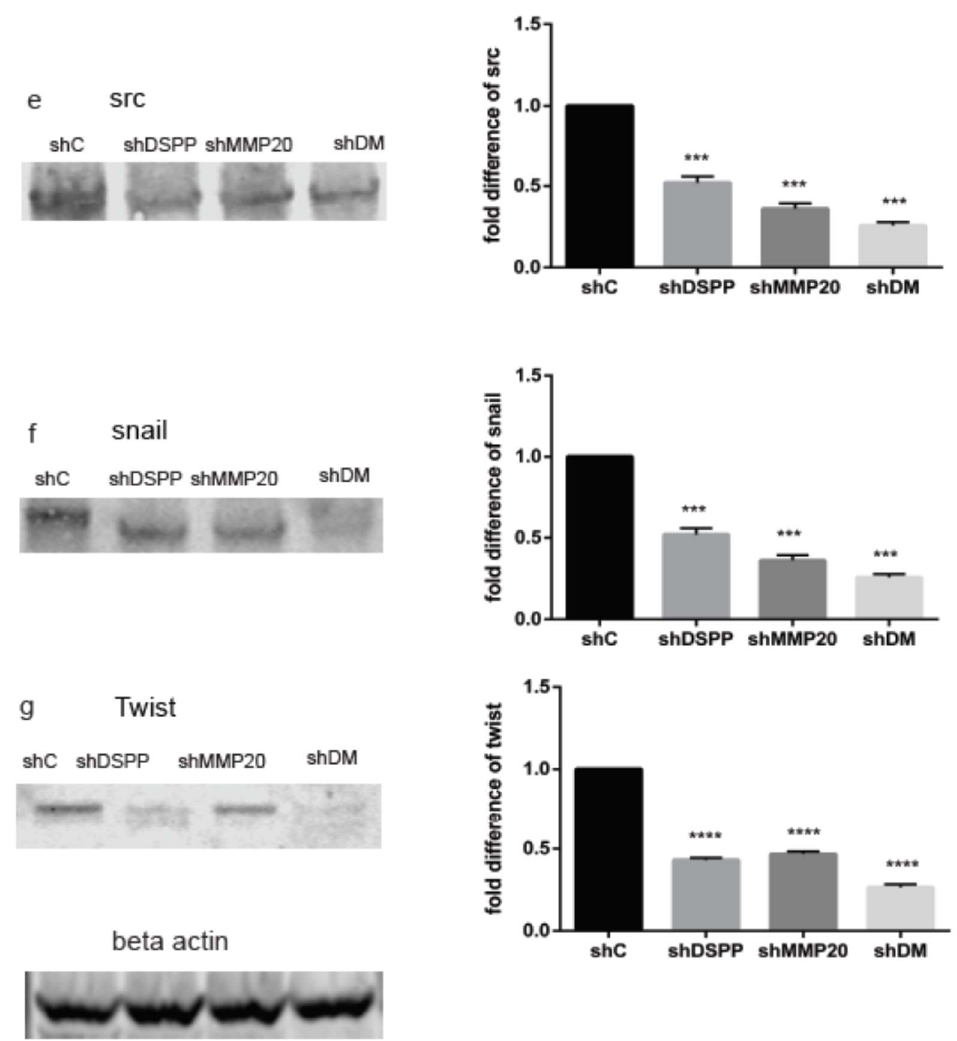
Figure 4. WB analysis of proteins associated with epithelial-mesenchymal transition. ( a ) Increase in level of E-cadherin (2-fold in shDSPP, 1.6-fold in shMMP20, and 1.8-fold in shDM ( p < 0.01, p < 0.05, p < 0.05, respectively) when compared to the control. ( b ) Decreased N-cadherin in shDSPP (93%), shMMP20 (54%), and shDM (84%) were significant ( p < 0.05) when compared to the control. ( c ) Decreased vimentin in shDSPP (73%), shMMP20 (55%), and shDM (79%) were significant ( p < 0.01, 0.001) when compared to the control. ( d ) Downregulation of met in shDSPP (80%), shMMP20 (30%), and shDM (47%) were significant ( p < 0.01) when compared to the control. ( e ) Downregulation of src (Figure 4e) in shDSPP (60%), shMMP20 (75%), and shDM (85%) were significant ( p < 0.01) when compared to the control ( f ) Downregulation of snail in shDSPP (46%), shMMP20 (60%), and shDM (74%) were significant ( p < 0.05) when compared to the control. ( g ) Downregulation of twist in shDSPP (44%), shMMP20 (50%), and shDM (70%) were significant ( p < 0.001) when compared to the control. Beta actin was used as the internal control. Values are given as mean ± SE for 3 independent experiments. shC = Scrambled Control; shDSPP = DSPP Silenced OSC2 cells; shMMP20 = MMP20 Silenced OSC2 cells; DM = Combined DSPP–MMP20 Silenced OSC2 cells; * p < 0.05; ** p < 0.01; *** p < 0.001; **** p < 0.0001.